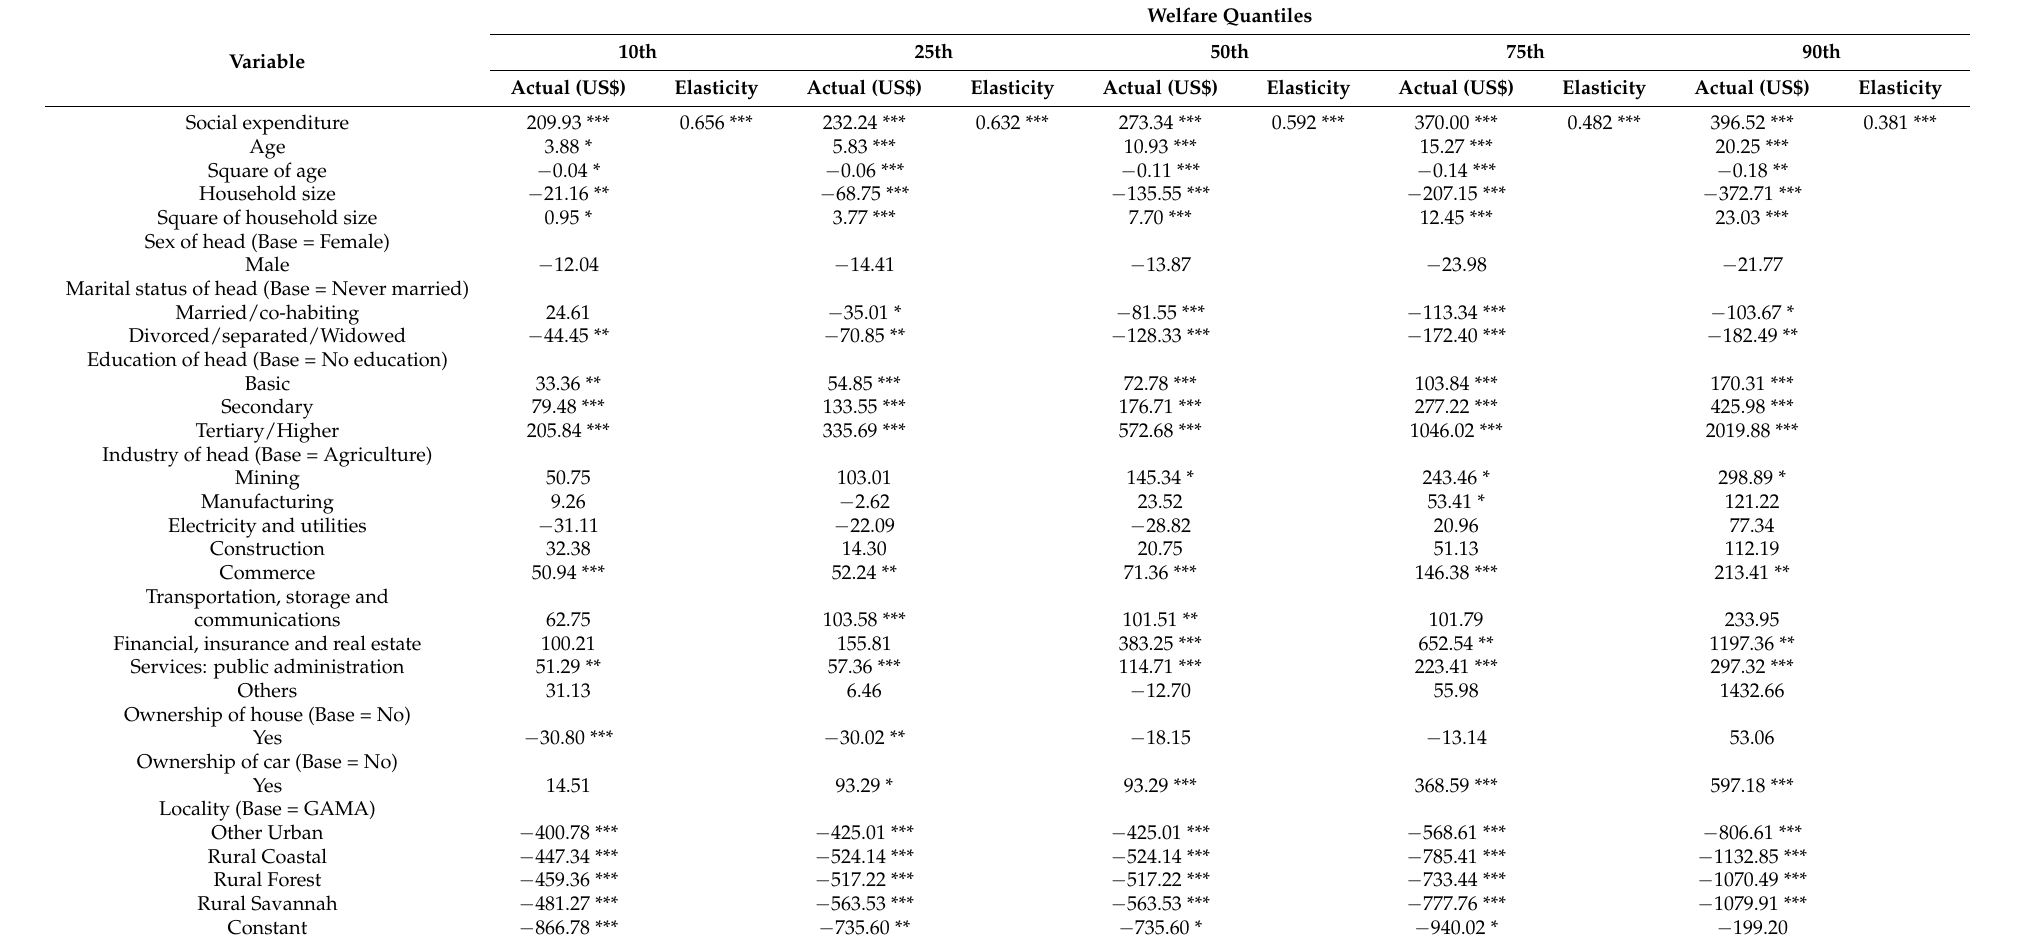
Table 1. Quantile effect of social expenditure on household welfare,